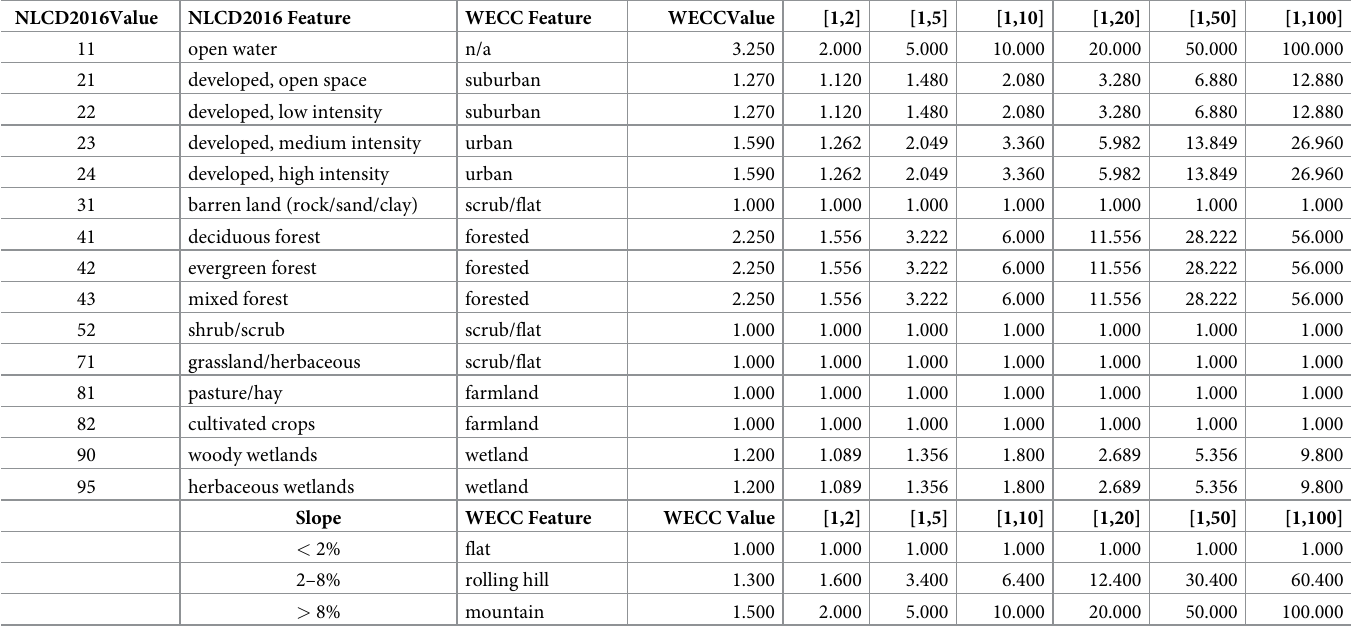
Table 1. Attribute reclassification for fixed C min and varying